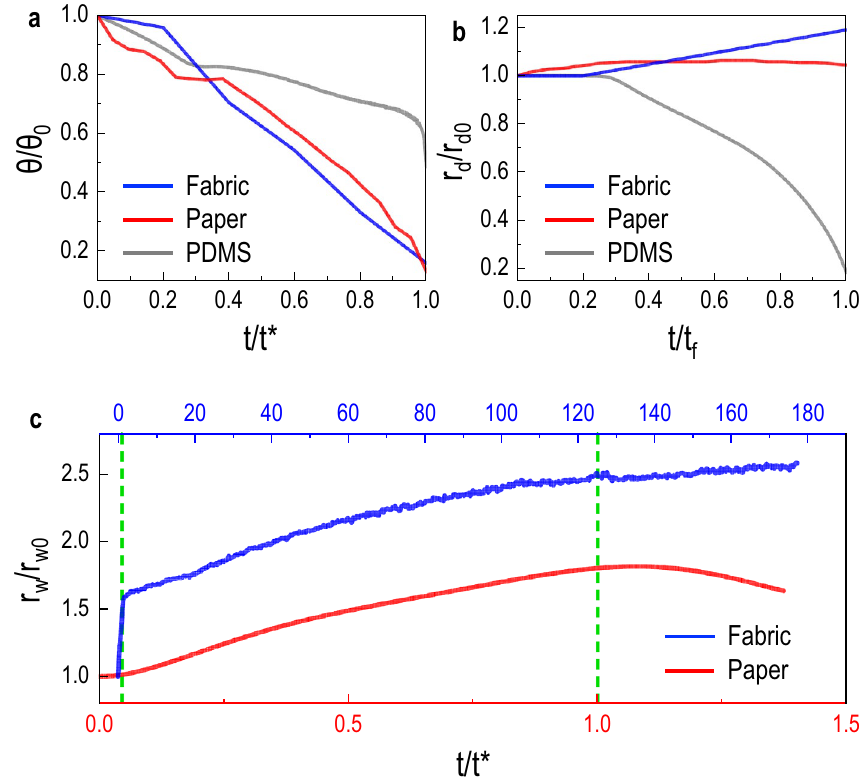
Figure 4. Spreading and imbibition dynamics. (a) Contact angle θ decay for the different substrates. The contact angle θ was normalized with the respective initial value θ 0 for each substrate and the time t was normalized with the characteristic time constant t ∗ corresponding to the moment of θ = 0 ◦ . For the fabric and paper substrates, t ∗ specifically refers to when θ ≈ 0 ◦ . (b) Droplet contact radius r d with time t for the different substrates. This graph represents the normalized values to the initial droplet radius r d 0 and the final time t f . (c) Wetted area radius r w for the porous samples (fabric and paper). The r w values are normalized to its initial values r w 0 and the time is normalized to the characteristic time constant t ∗ . The green lines represent the moment when θ ≈ 0 ◦ for each